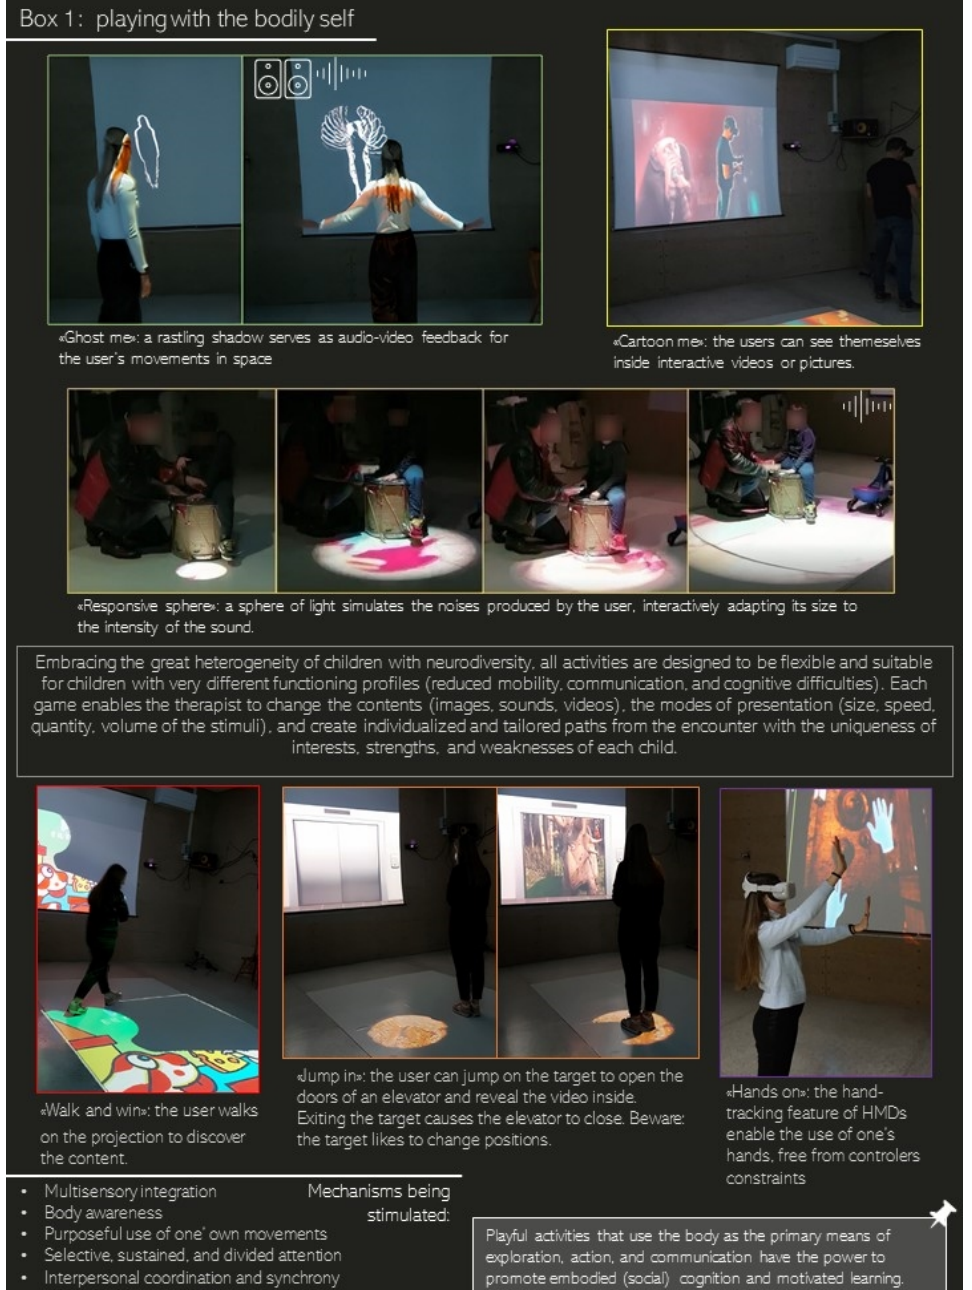
Figure 2. Examples of multimedia- and IVR-gamified activities to simultaneously foster sensorimotor, social, and cognitive mechanisms contributing to the bodily-self experience. These activities are suitable for both M. (for whom the bodily self seems fragile and a source of distress) and A. (for whom the bodily self appears a strong source of